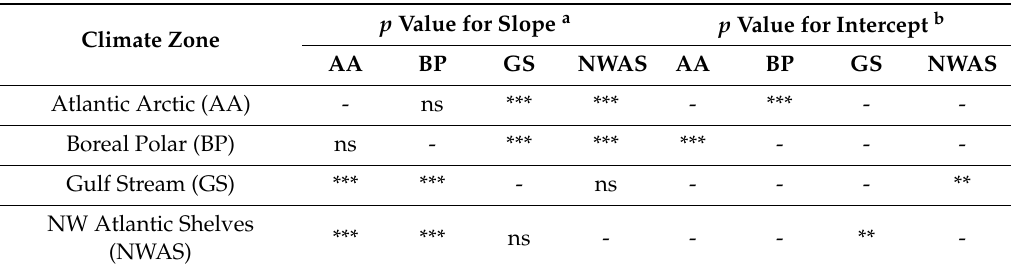
NW Atlantic Shelves *** *** ns - - - - (NWAS)